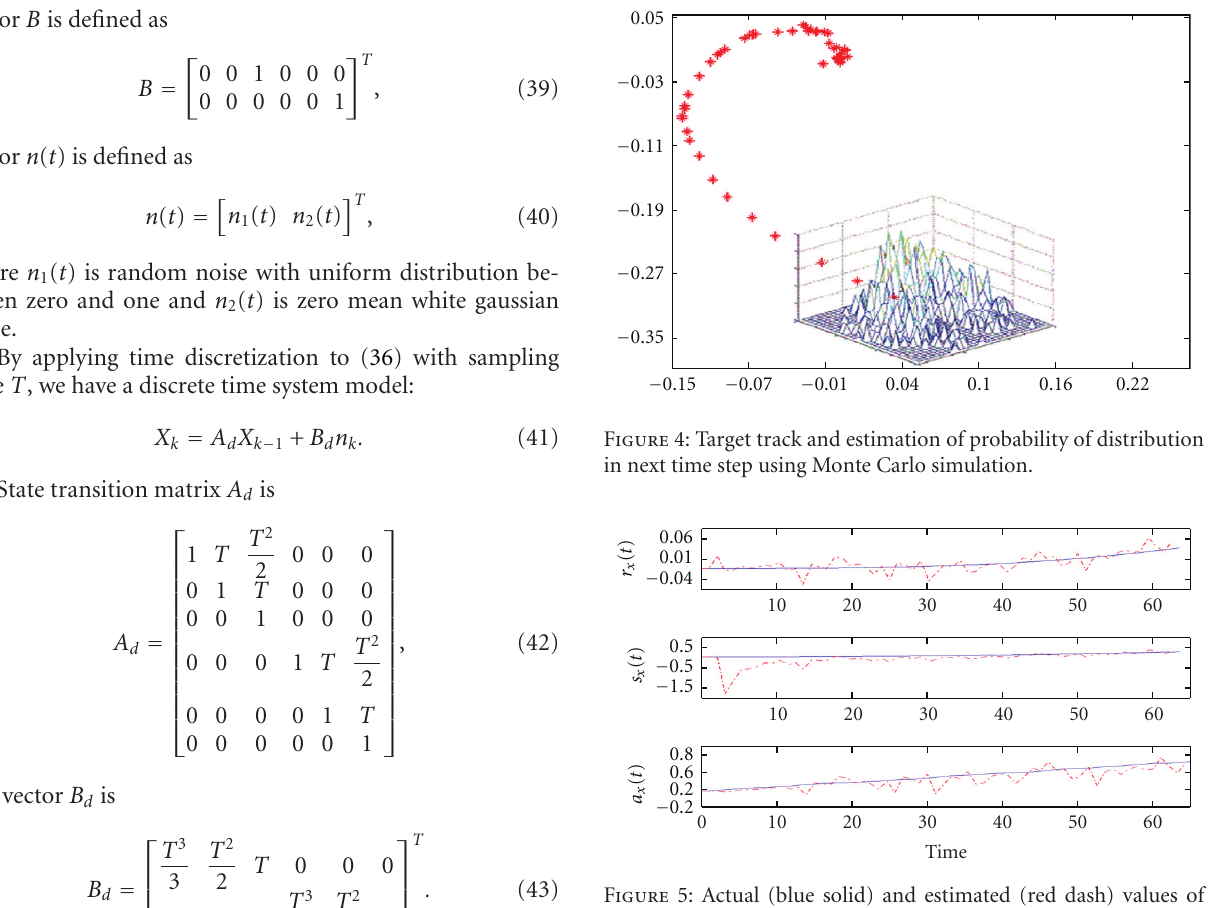
Figure 5: Actual (blue solid) and estimated (red dash) values of r x ( t ), s x ( t ), and a x ( t ) in centric coordinate system.